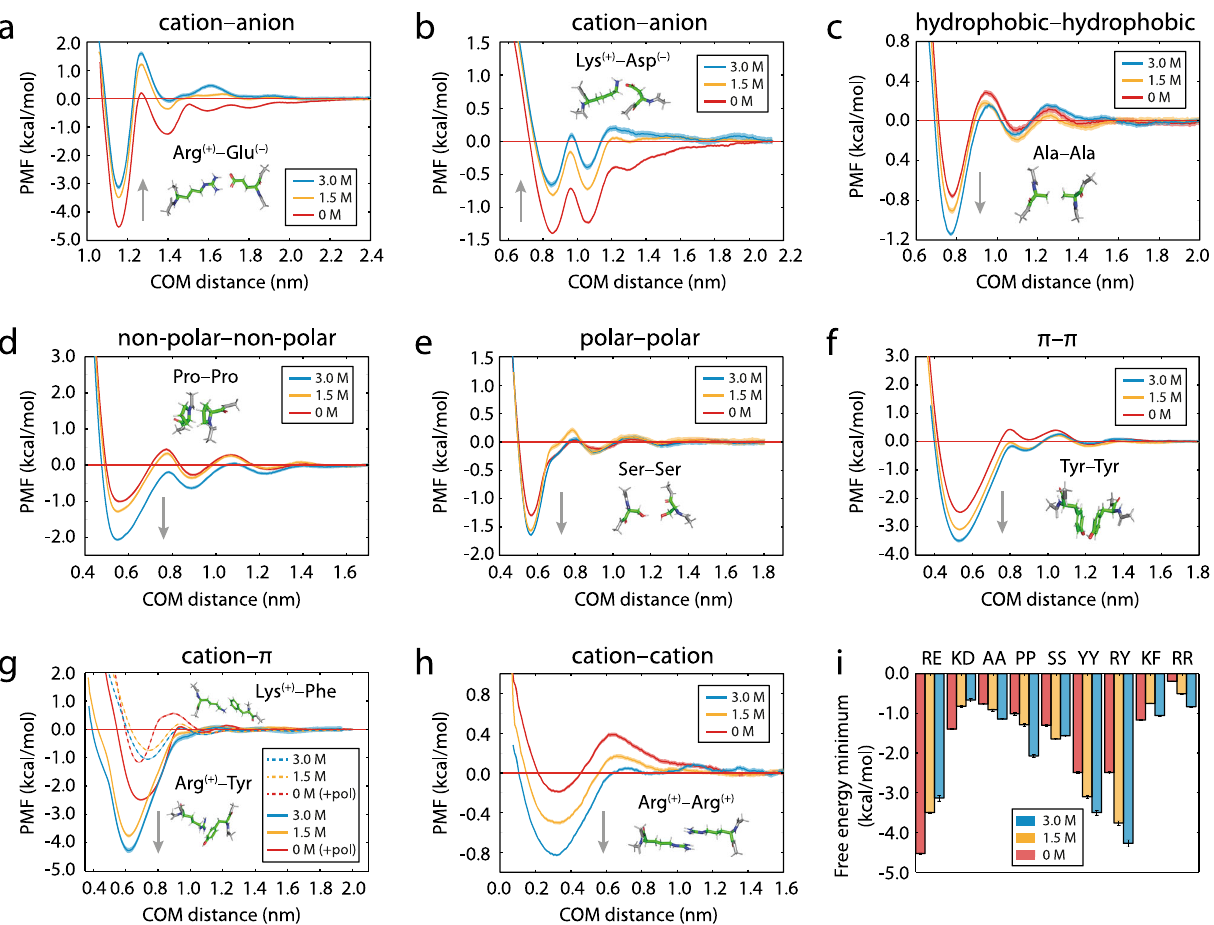
Fig. 6 Effect of salt (0 M, 1.5 M, 3 M NaCl) on the potential of mean force (PMF) between selected amino acid pairs in explicit solvent and NaCl ions as a function of the center-of-mass (COM) distance. a Cation – anion (with π – π contributions), b cation – anion (without π – π contributions), c hydrophobic – hydrophobic, d non-polar – non-polar, e polar – polar, f π – π , g hybrid cation – π / π – π (Arg – Tyr, solid lines) and cation – π (Lys – Phe, dashed lines) ( + pol denotes re fi tted Tyr/Phe parameters were employed; as described in the text and Supplementary Information), h Cation – cation (with π – π contribution). The second well in ( b ) emerges from the interaction of Asp with an additional H atom in the Lys sidechain, which is displaced by ~1.7 Å from the two H atoms that contribute to the fi rst well. To evaluate ( g ), a model for the polarized cation – π systems was developed (see “ Methods ” ). The gray arrows in each panel highlight the general shift direction of the PMF minimum as salt concentration is raised. Upward arrows show the weakening of cation – anion interactions upon increasing salt. Downward arrows show strengthening of nonionic interactions and of hybrid cation – π / π – π and cation – cation interactions when both amino acids in the pair have π – orbitals. Statistical errors, mean ± s.d., are shown as bands; obtained by bootstrapping the results from n = 3 independent simulations. i Variation in the free-energy minimum (obtained from the pro fi les in a – h , mean ± s.d.) with salt. One-letter amino acid codes are used to identify each pair interaction. Source data are provided as a Source Data fi